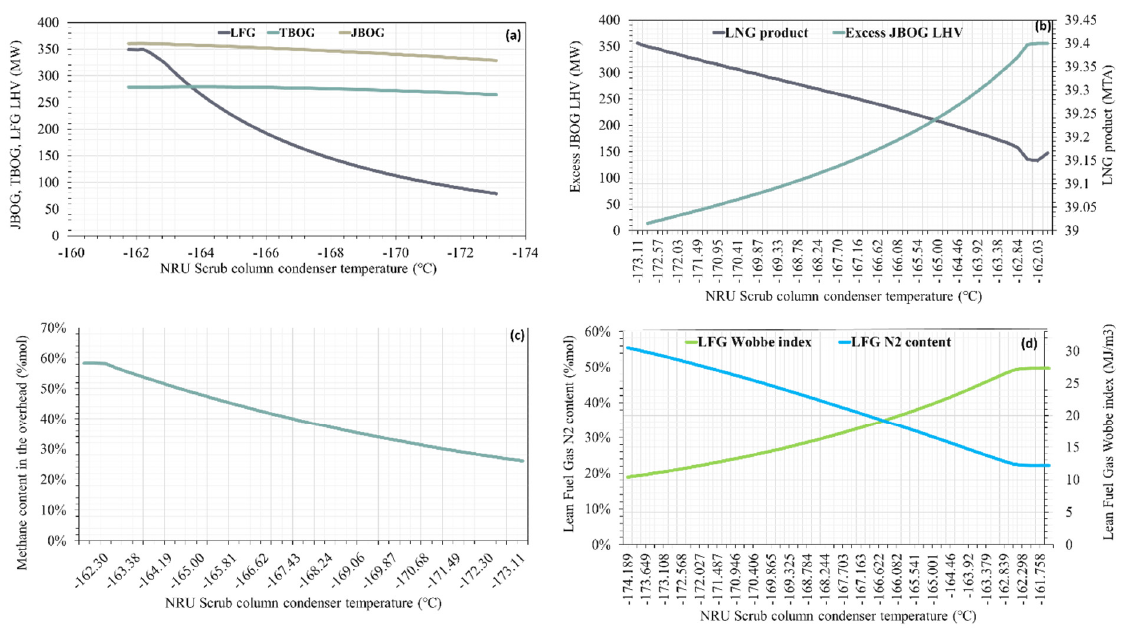
Figure 9. Effect of NRU reflux condenser temperature on ( a ) BOG and LFG, ( b ) excess JBOG and LNG production, ( c ) methane content of LFG, and ( d ) nitrogen content and Wobbe index of LFG.